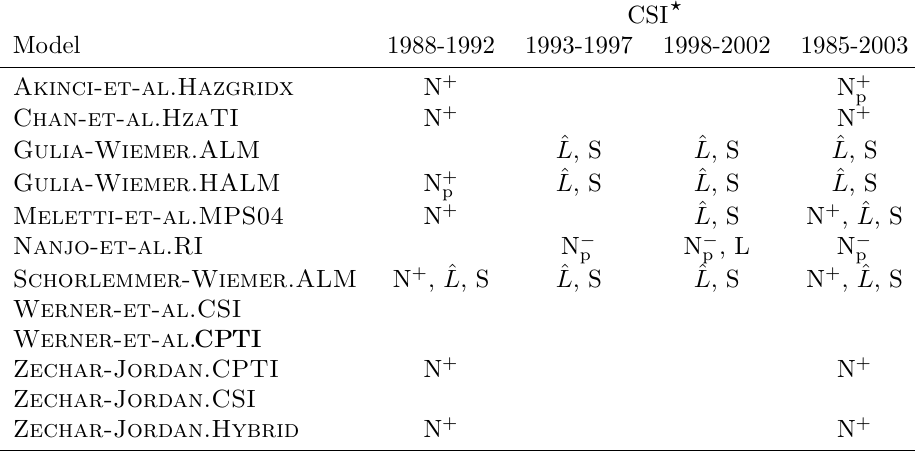
Table 2. Summary results of the forecast tests obtained using the CSI. *For each model and each experiment time period, the tests that the forecast failed are indicated, according to a 5% critical significance value. For the N-Test, N + indicates that the forecast overpredicted the observed rate, N – indicates underprediction; the subscript p indicates that the forecast only failed when assuming a Poisson uncertainty; otherwise it failed under both the Poisson and